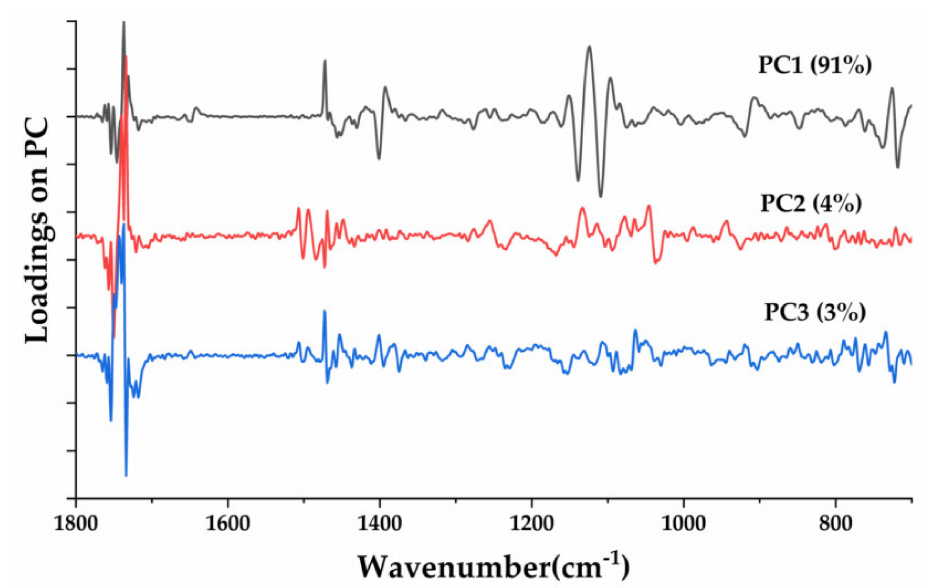
Figure 6. PCA loadings of CAO and CAO / RSO admixtures in the wavenumber region 1800–650 cm − 1 . CAO, camellia oil; RSO, rapeseed